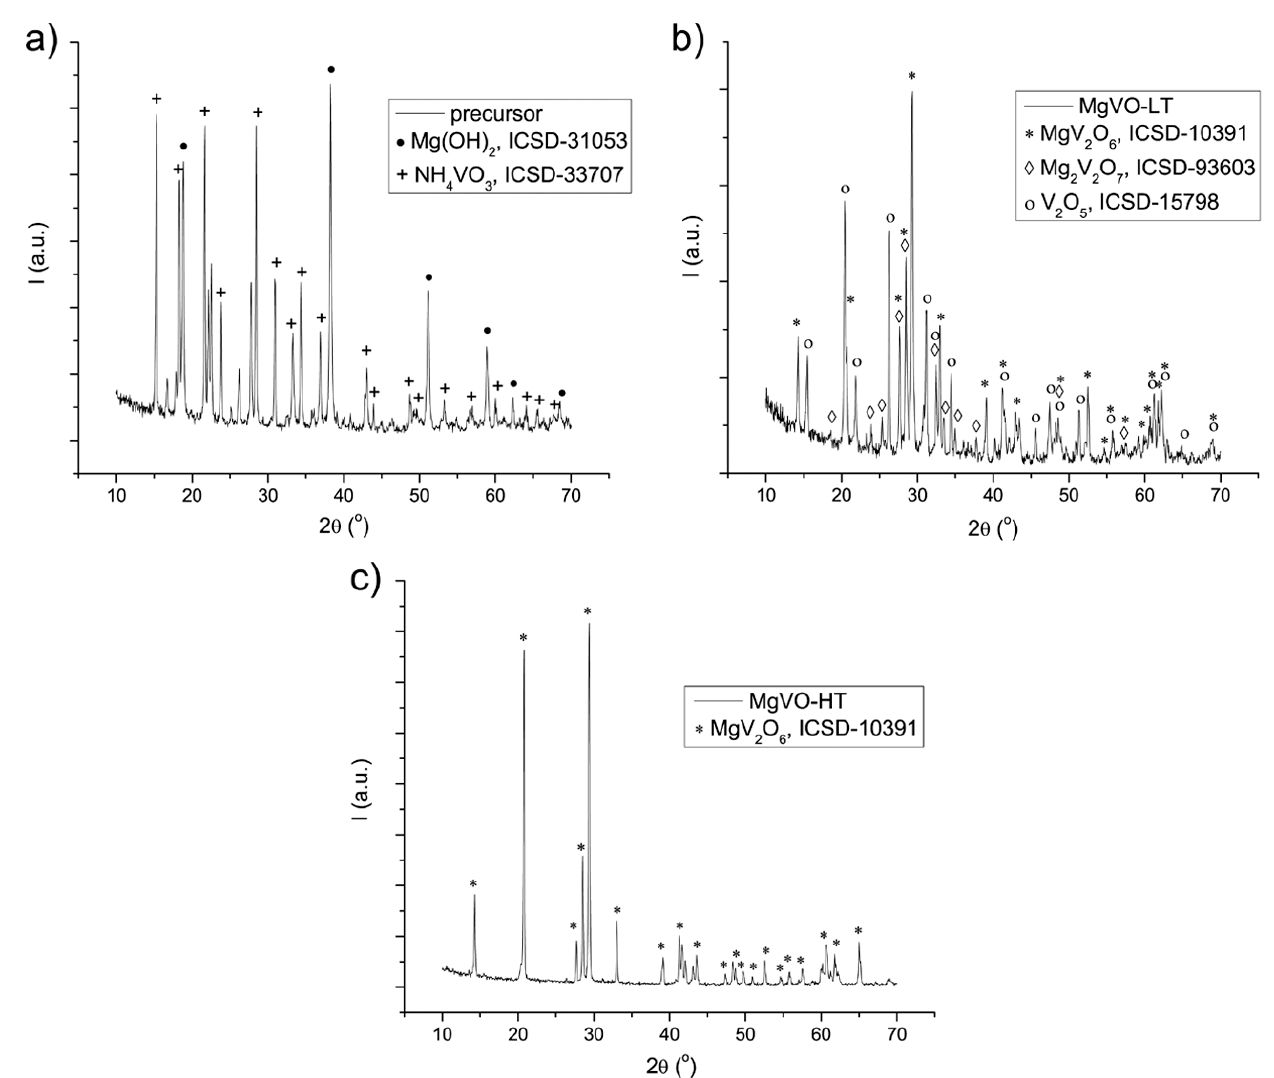
Figure 1. XRD patterns of the MgVO precursor ( a ); MgVO-LT ( b ); and MgVO-HT ( c ) material.